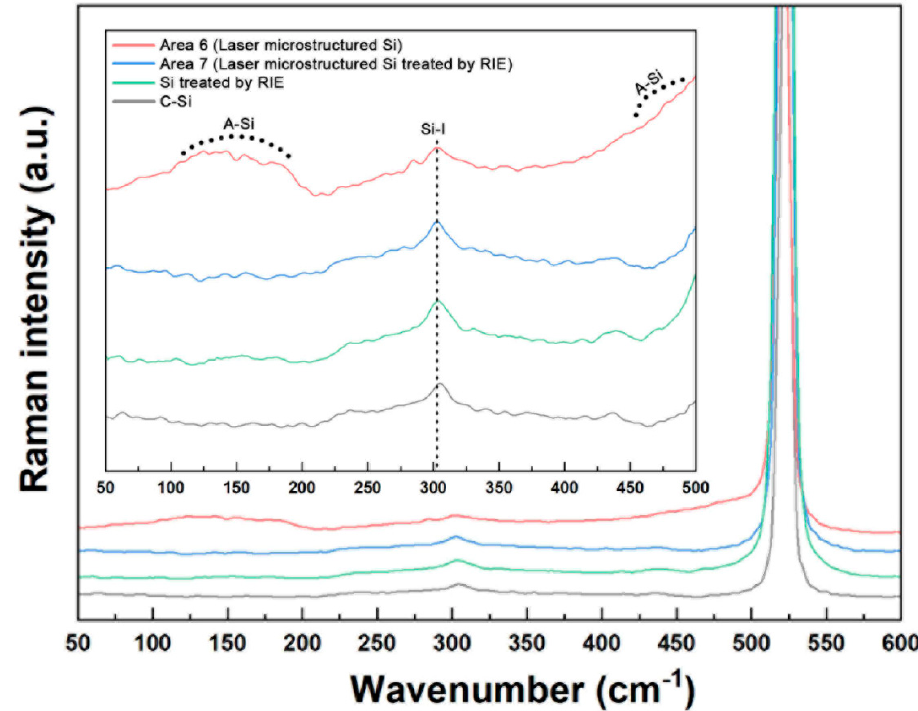
Figure 3. Raman spectra of laser-microstructured Areas 6 and 7. A Si only treated by RIE and a monocrystalline Si (C-Si) are given as a comparison.